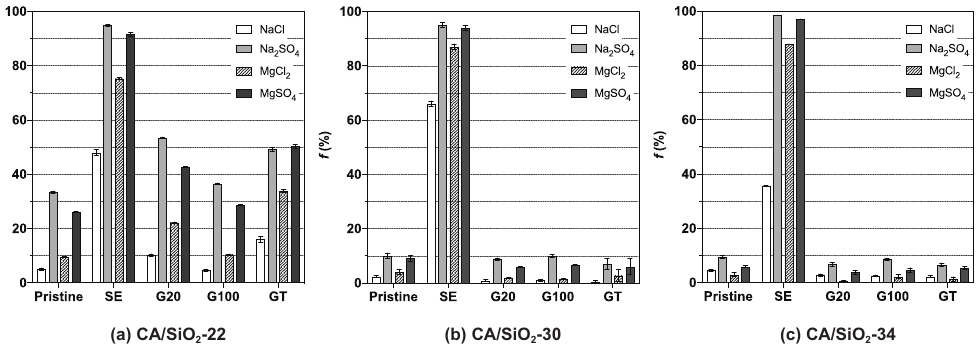
Figure 6. Apparent rejection coefficient to salts, f , of ( a ) CA/SiO 2 -22, ( b ) CA/SiO 2 -30 and ( c ) CA/SiO 2 -34